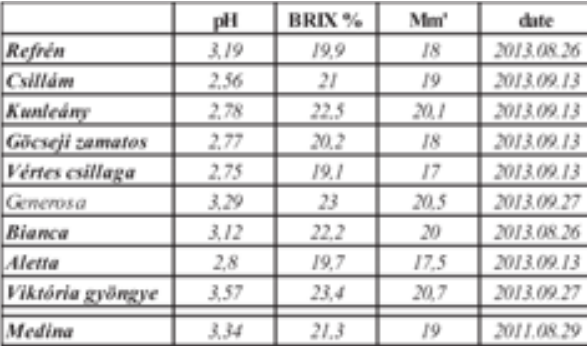
Table 2. Basic quality parameters of cultivars in trials